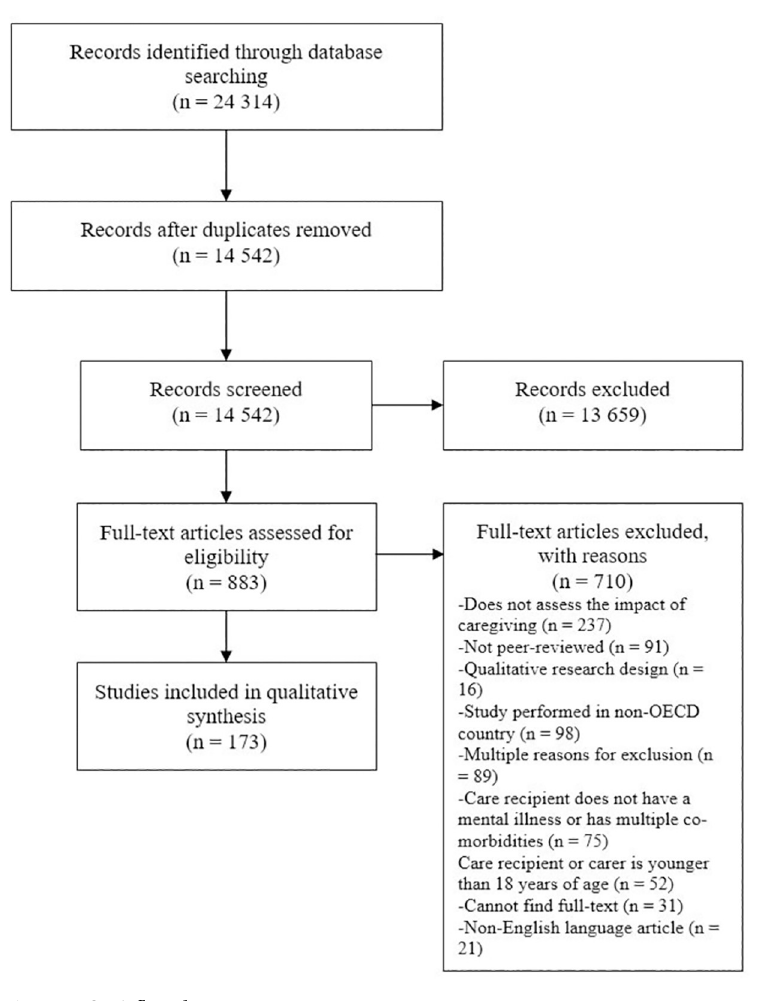
Fig 1. PRISMA flow